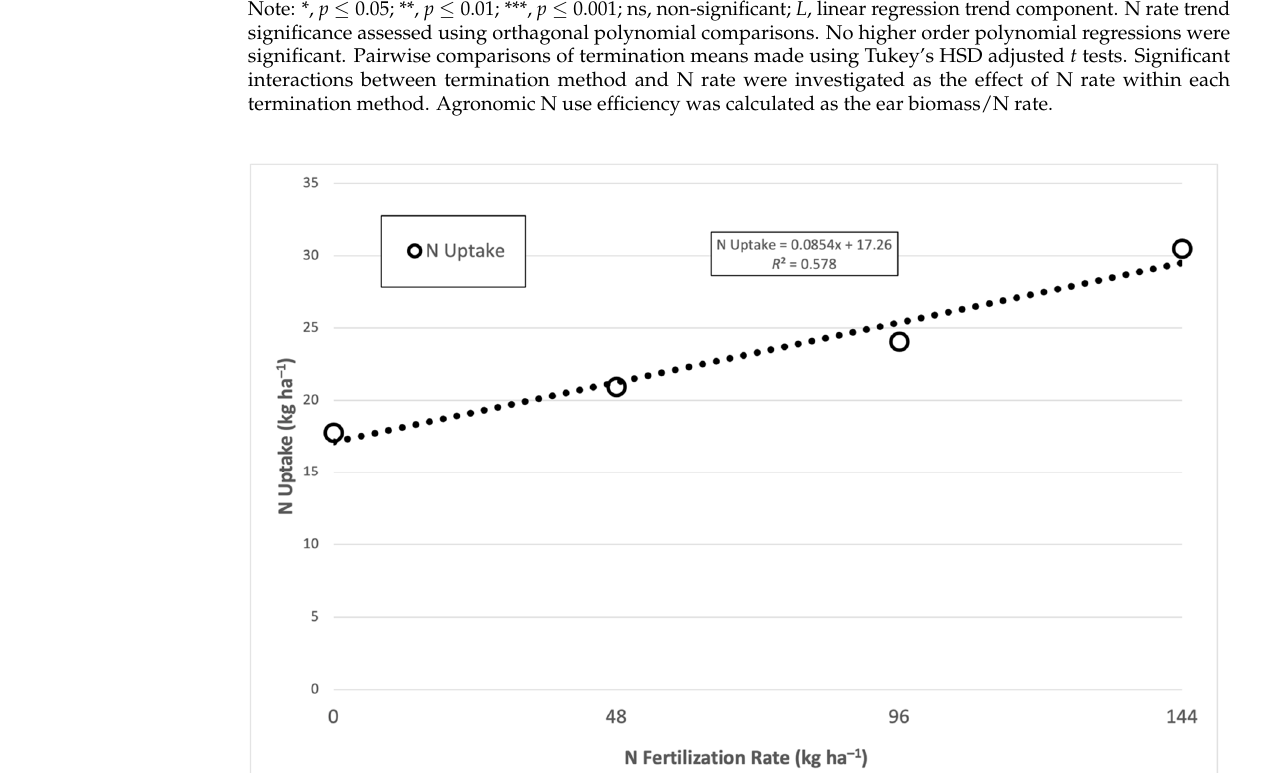
Figure 11. Mean agronomic N use efficiency in sweet corn as a function of N fertilization rate in 2020 and 2021. Goodness of fit described with conditional R 2 .